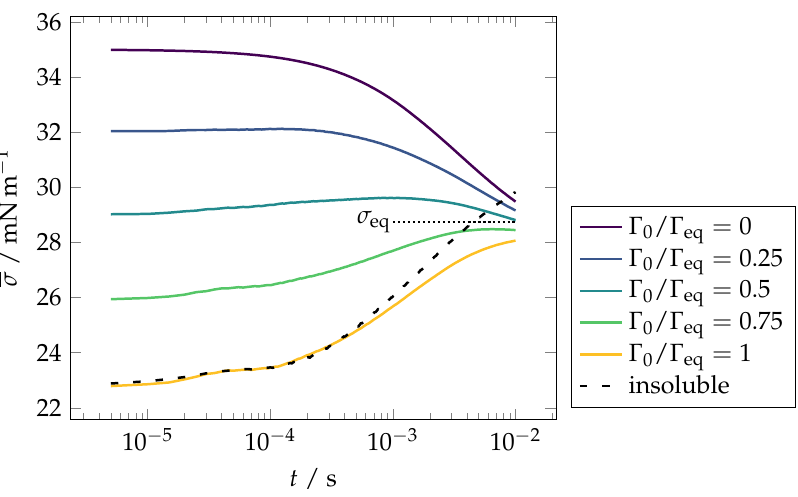
Figure 9. Influence of the initial surfactant concentrations on the mean surface tension. The equilibrium surface tension σ eq = 28.74mNm − 1 as expected for a spherical cap shaped droplet with the given volume and a contact angle of 12 ◦ is indicated by the dotted line.